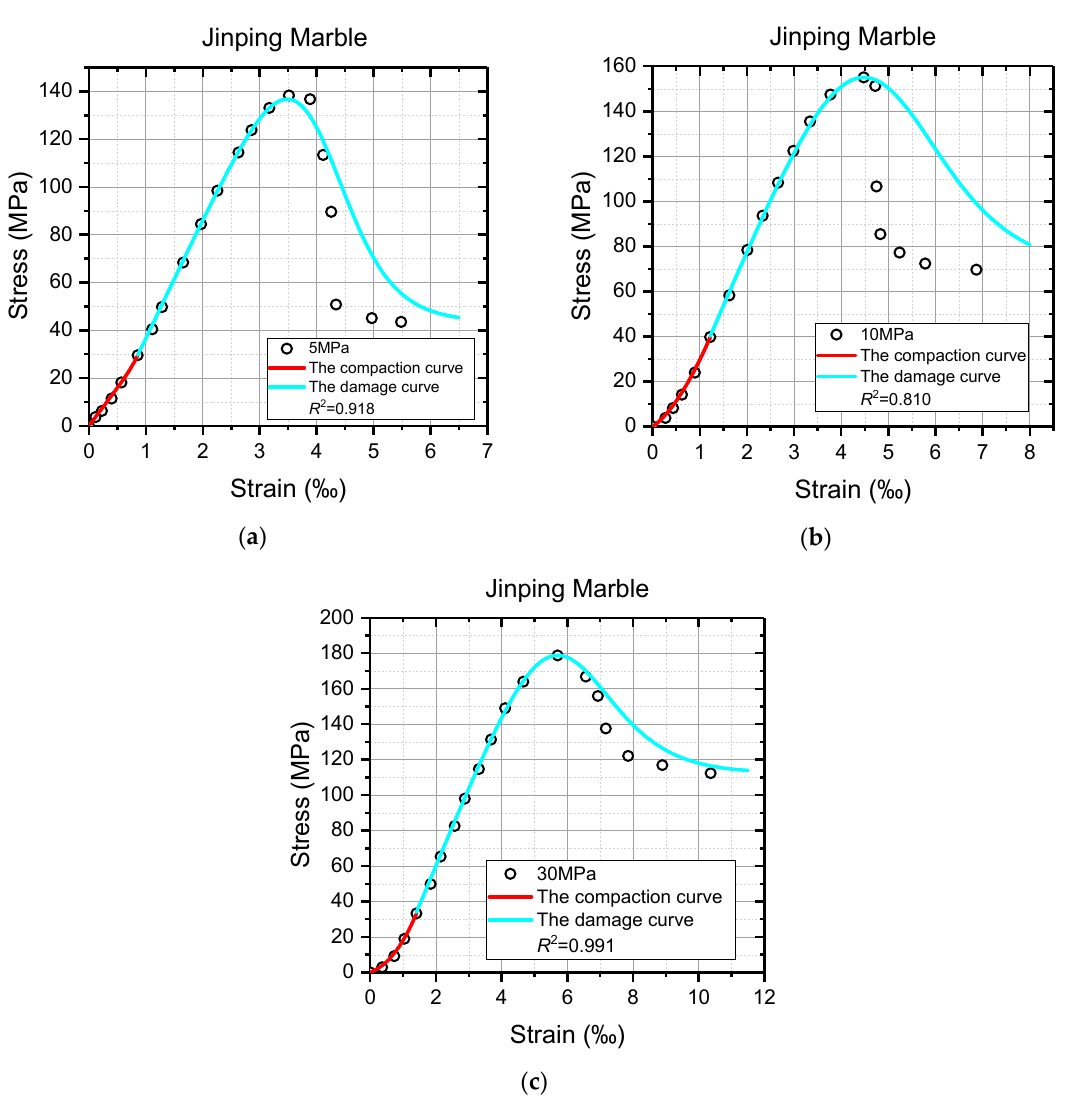
Figure 10. The comparison between partial triaxial test data and model curves of Jinping Marble. ( a ) Confining stress = 5 MPa; ( b ) confining stress = 10 MPa; ( c ) confining stress = 30 MPa.